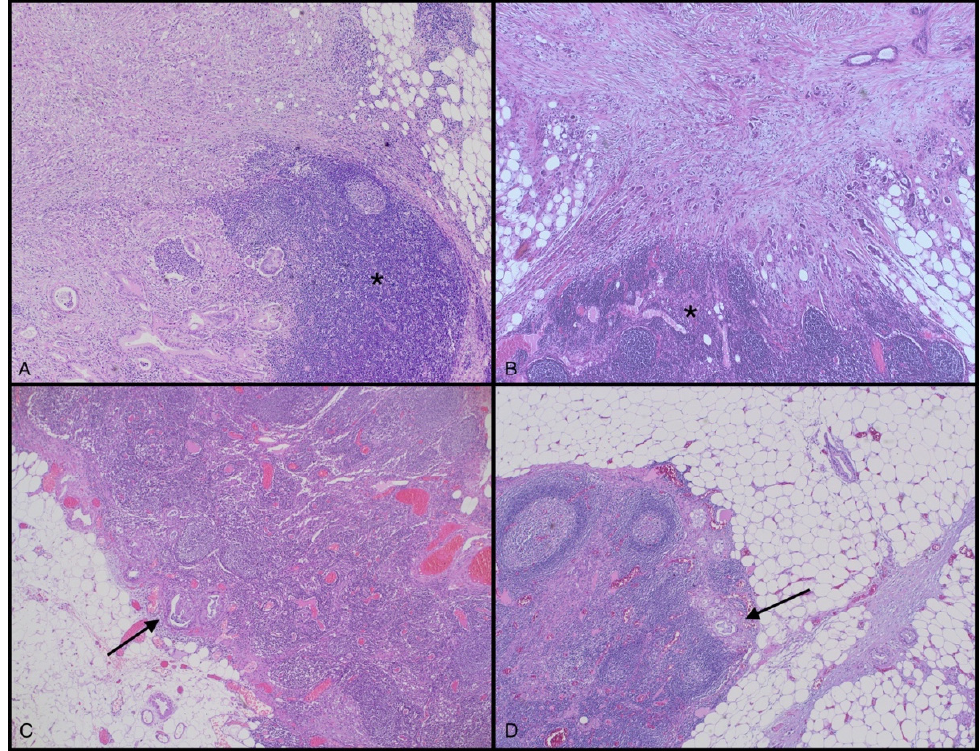
Figure 4. Direct lymph node involvement by PDAC (NI): Almost the whole left part ( A ) and more than an upper two-thirds ( B ) are occupied by solid PDAC growth, which directly invades the remnants of a lymph node (asterisks). This form of NI in PDAC has a different prognostic significance compared to a true metastatic spread (arrows in ( C , D )). See the text (Section 12) for further details on the topic. (H&E stain, original magnification ×4).